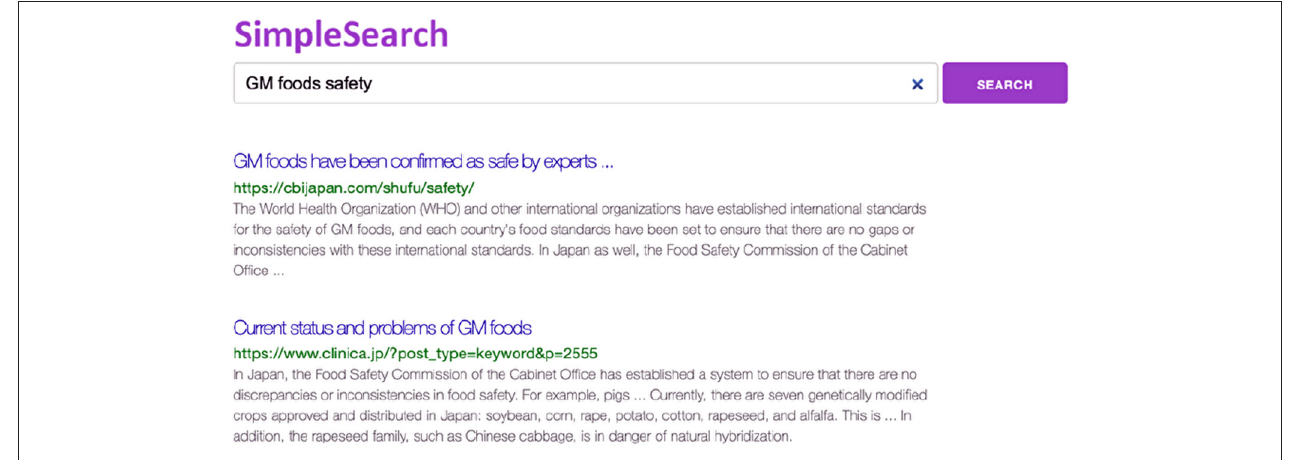
FIGURE 1 | SERP presented to participants in the user